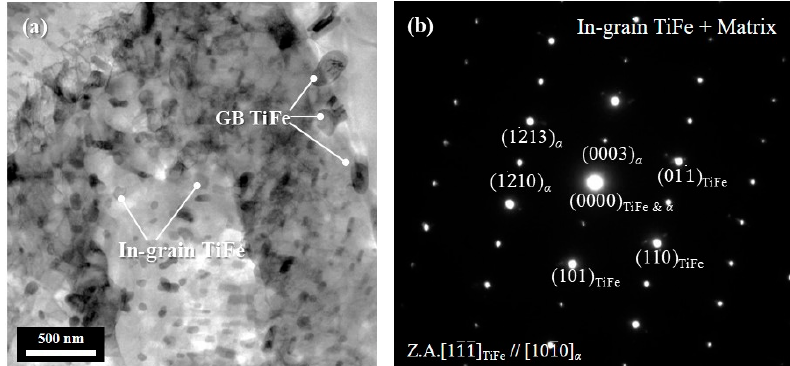
Figure 5. TEM analysis results of Ti-5Al-3.5Fe alloy after aging for 100 h. ( a ) Bright-field image and ( b ) corresponding diffraction